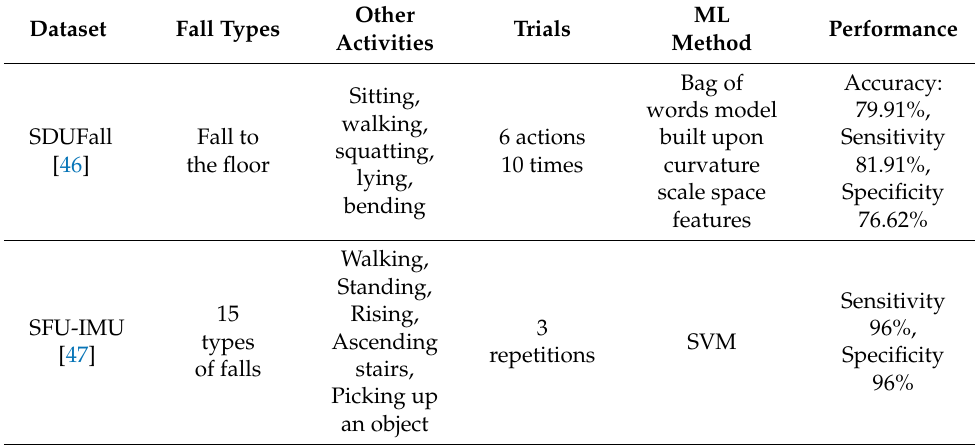
Table 2. Vision-based datasets for fall